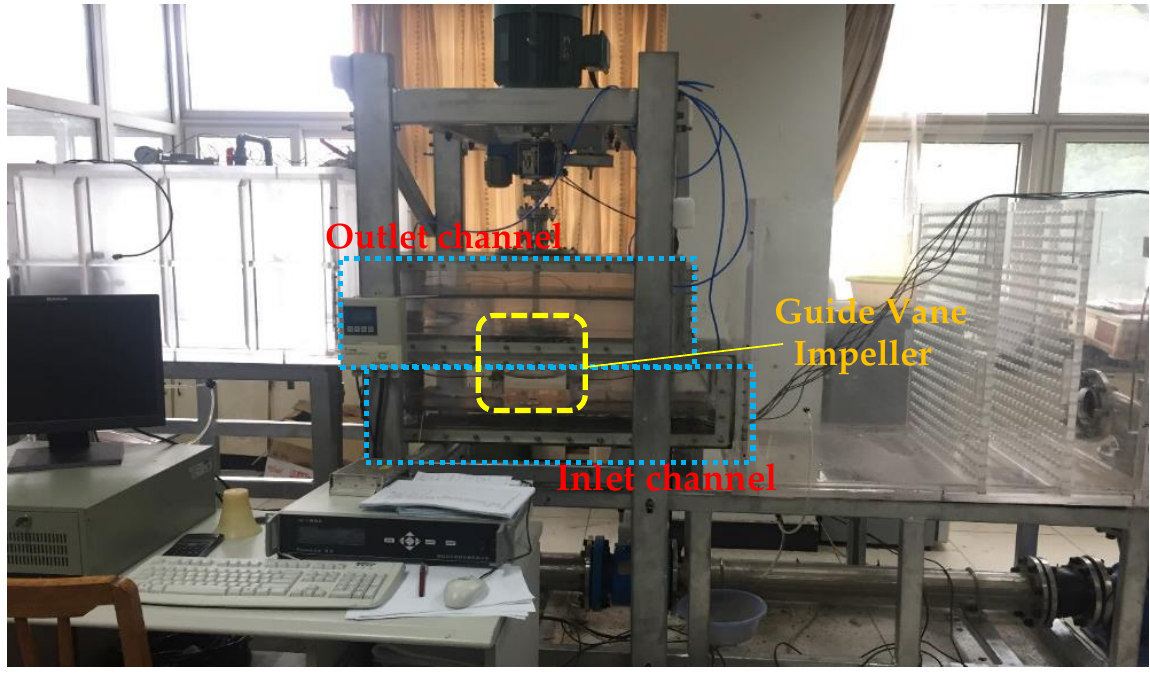
Figure 7. Diagram of the test setup.